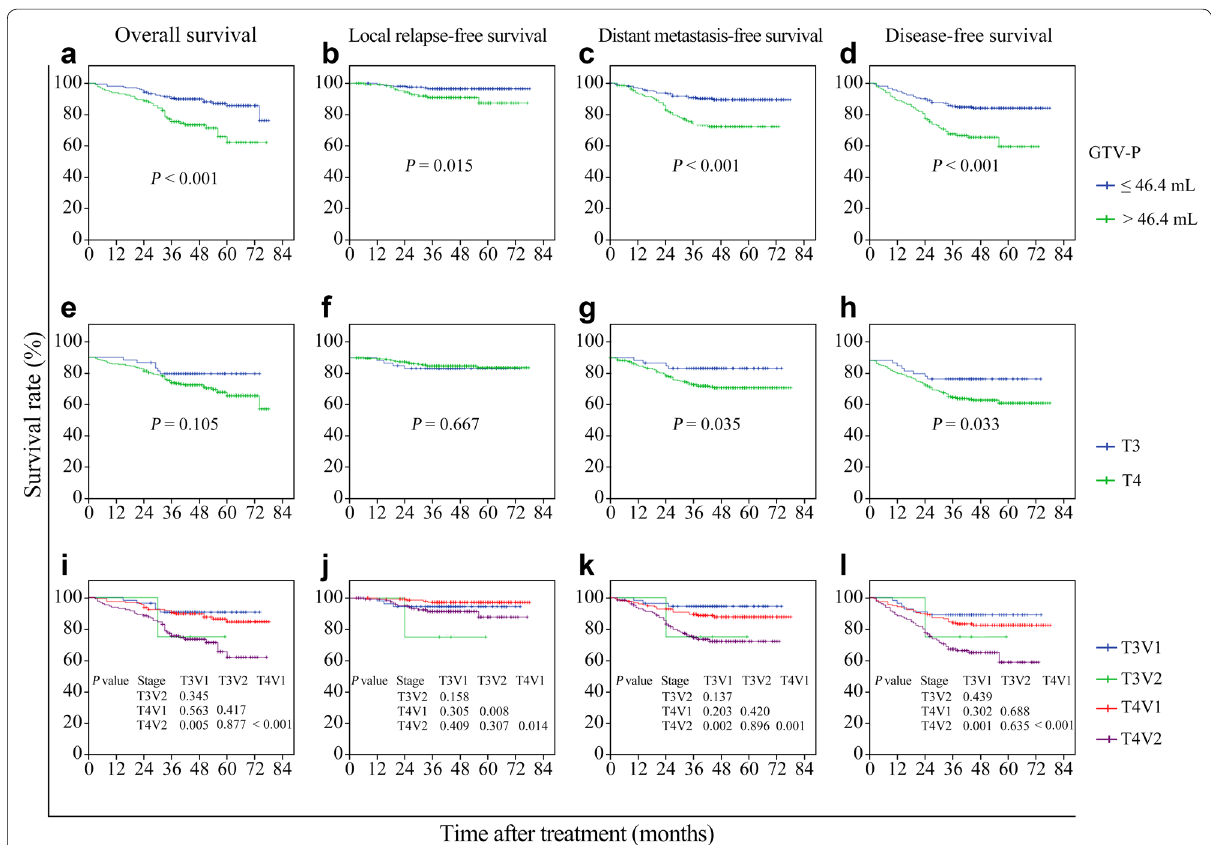
Fig. 3 Survival curves of locally advanced NPC patients with different GTV‑P and T categories. Patients with different GTV‑P had significant differ‑ ences in overall survival (OS) ( a) , local relapse‑free survival (LRFS) ( b ), distant metastasis‑free survival (DMFS) ( c ), and disease‑free survival (DFS) ( d ). Patients with different T categories were not different in OS ( e ) or LRFS ( f ), but had significant differences in DMFS ( g ) and DFS ( h ). T3 tumors were subclassified as T3V1 (T3 tumors with GTV‑P 46.4 mL) and T3V2 tumors (T3 tumors with GTV‑P >46.4 mL); T4 tumors were subclassified as T4V1 ≤ (T4 tumors with GTV‑P 46.4 mL) and T4V2 tumors (T4 tumors with GTV‑P >46.4 mL). Significant differences in OS ( i ), LRFS ( j ), DMFS ( k ), and DFS ( l ) ≤ were observed between patients with T4V1 and T4V2 tumors, but not between patients with T3V1 and T3V2